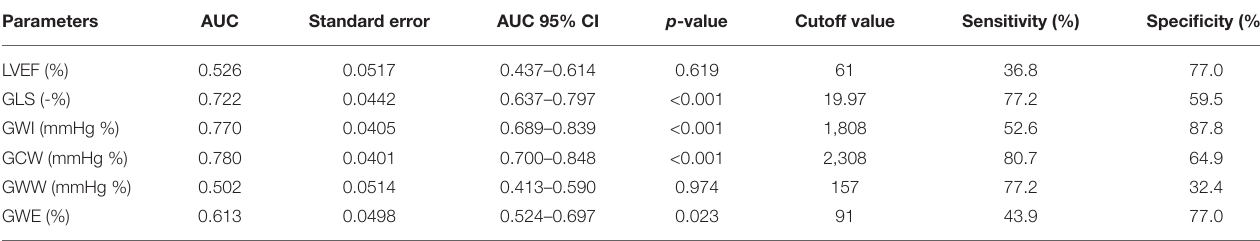
TABLE 4 | Receiver operating characteristic curve analysis of LVEF and global myocardial work parameters to identify high-risk SCAD. Parameters